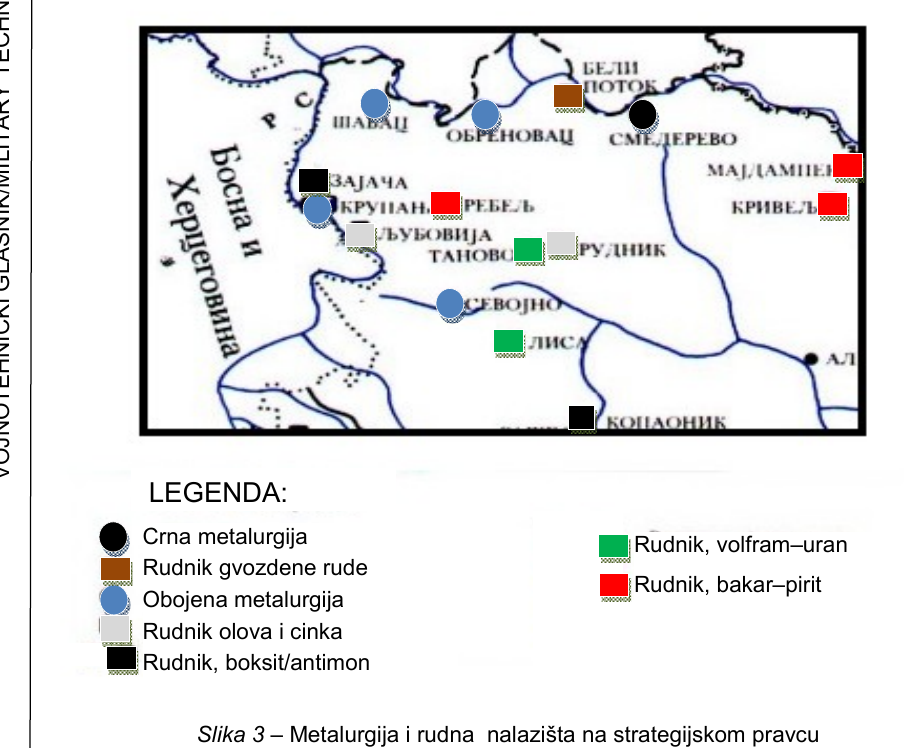
Figure 3 – Metallurgy and mineral deposits on the strategic